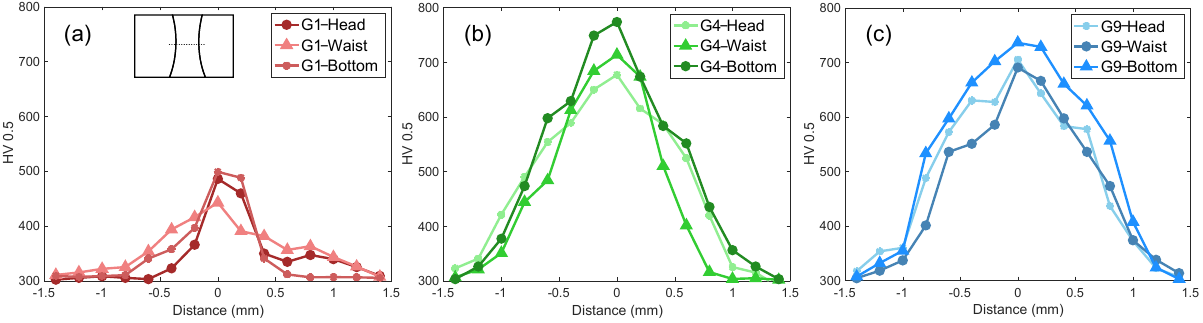
Figure 9. Vickers hardness curves along the direction perpendicular to the weld joining interface at the center area of specimens in Group 1 ( a ), Group 4 ( b ), and Group 9 ( c ). The maximum Vickers hardness (MVH) values of specimens of the nine groups’ welded joint are illustrated in Figure 5. The MVH values varied from 476 ± 30 HV 0.5 to 767 ± 40 HV 0.5 . The effect of the set value of Ss on the MVH value was evident: the values of MVH in Groups 1–3 with a smaller set value of Ss became smaller than those of other groups with higher set values of Ss. As a matter of fact, the increase in the set values of Ss will consequently raise the temperature within the joined interface regions, generating a more thermoplastic metal, which inclines to form martensite microstructures at the high air-cooling rate, thus making the values of MVH increase, while the set value of Up generates the opposite influence. Groups 1, 6, and 8 with the maximum set value of Up (175 MPa) received the smallest values of MVH among the 3-Group with the same set values of Ss. In fact, the extrusion of the high-temperature thermoplastic metals by the high set value of Up resulted in a remarkable decrease in the value of MVH, which is favored by the CDFW joint